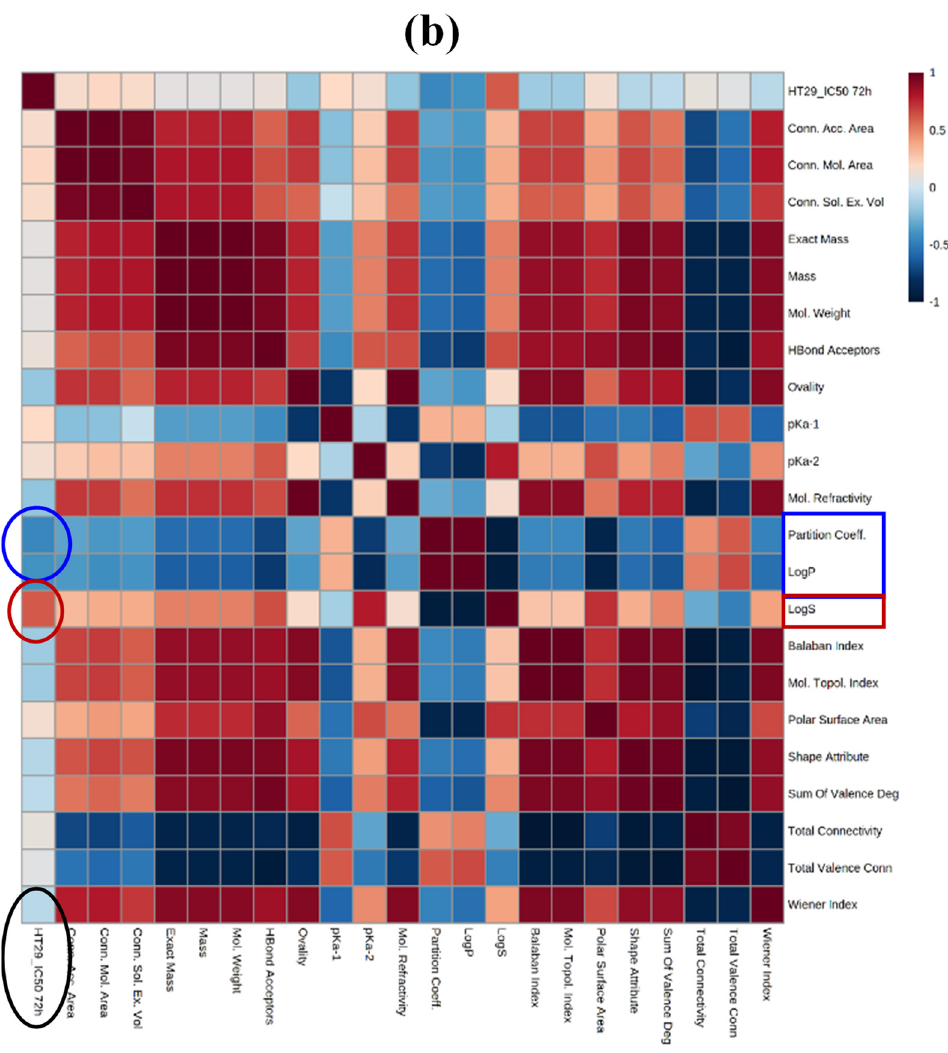
Figure 5. Heat map showing the correlations (Spearman) between the main variables considered and the IC 50 values after 72 h for Caco-2 ( a ) and HT-29 ( b ) cells. Darker red means a higher direct correlation, and darker blue indicates a higher inverse correlation.